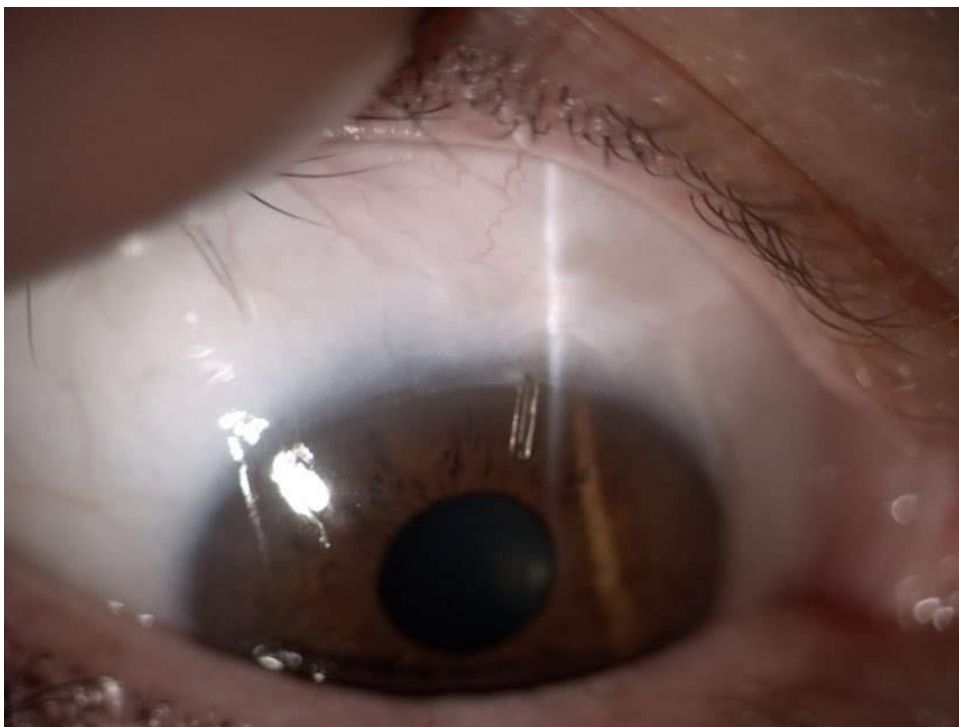
Figure 3. Avascular filtering bleb after Preserflo Microshunt implantation.